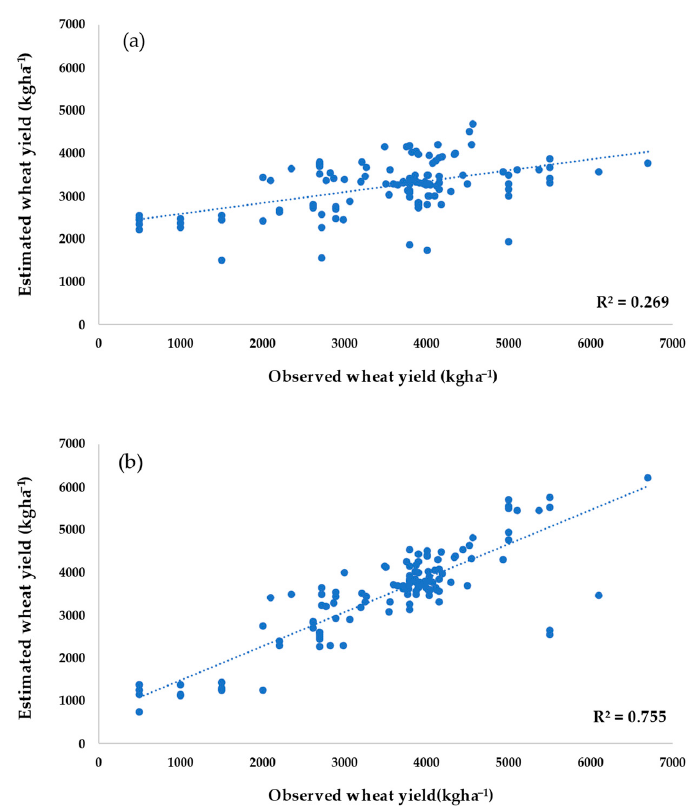
Figure 5. Relationship between simulated and observed wheat grain yields for ( a ) minimum data input scheme (rainfed parcels), and ( b ) medium data input scheme (rainfed parcels).